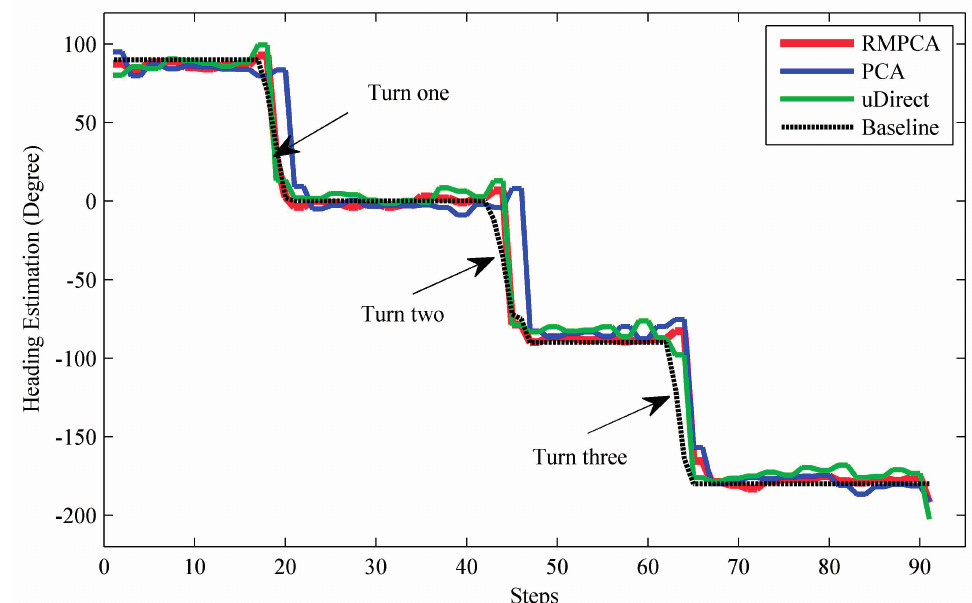
Figure 9. Heading estimations of different approaches vs.